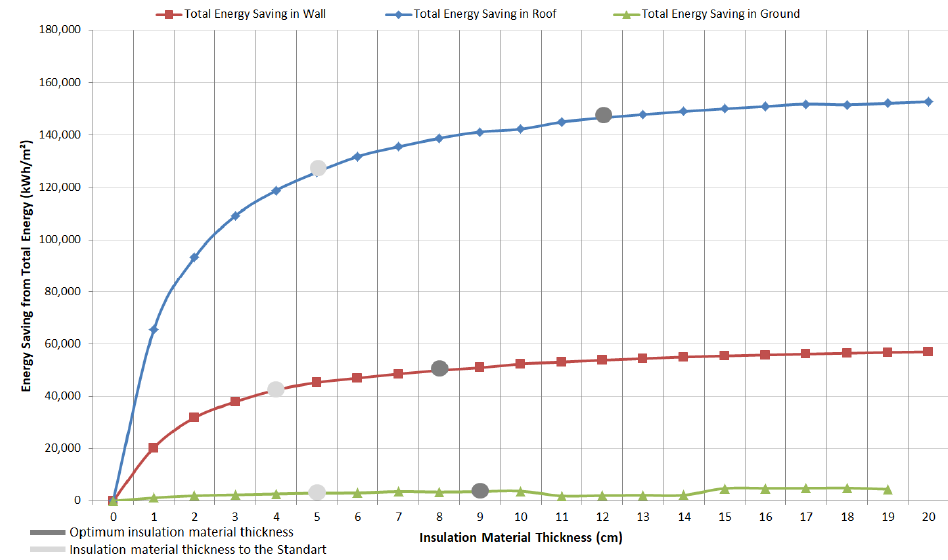
Figure 7. The curves of energy saved by increasing the thickness of the insulation material.